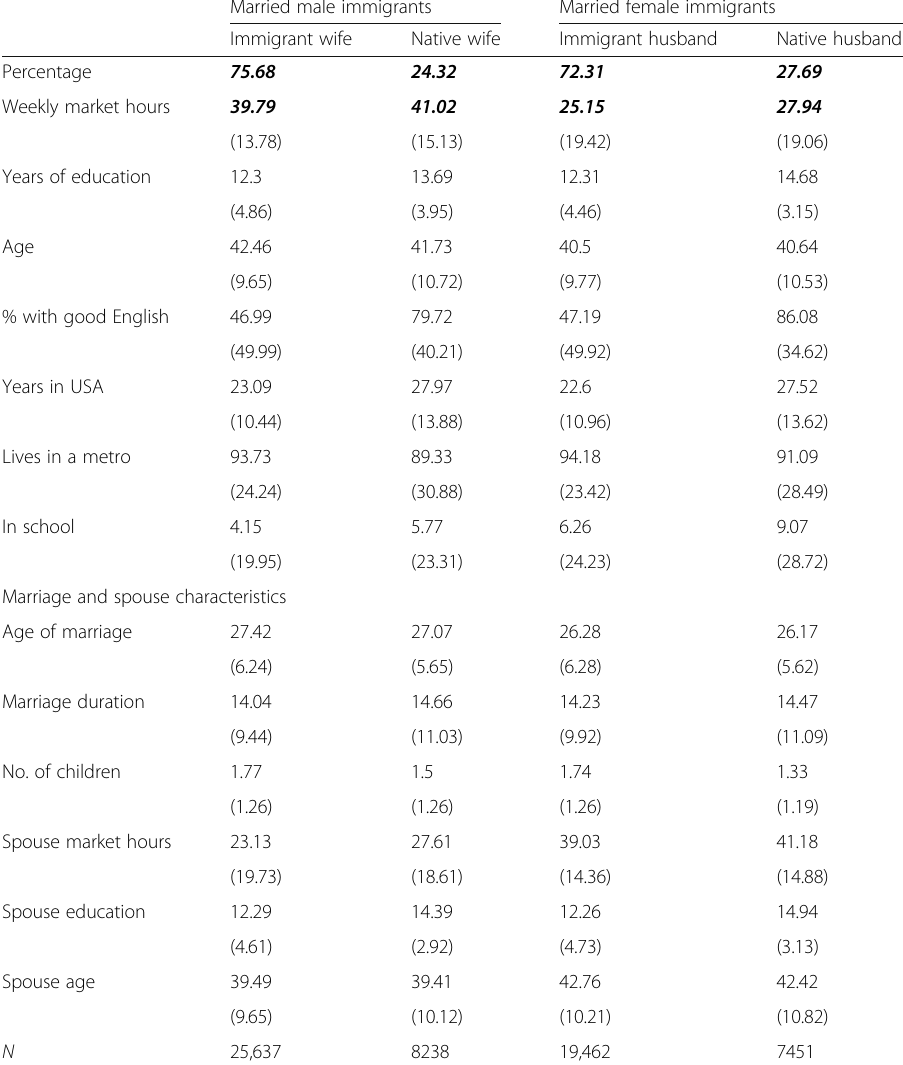
Table 1 Descriptive statistics of married immigrants: by type of marriage Married male immigrants Married female immigrants Immigrant